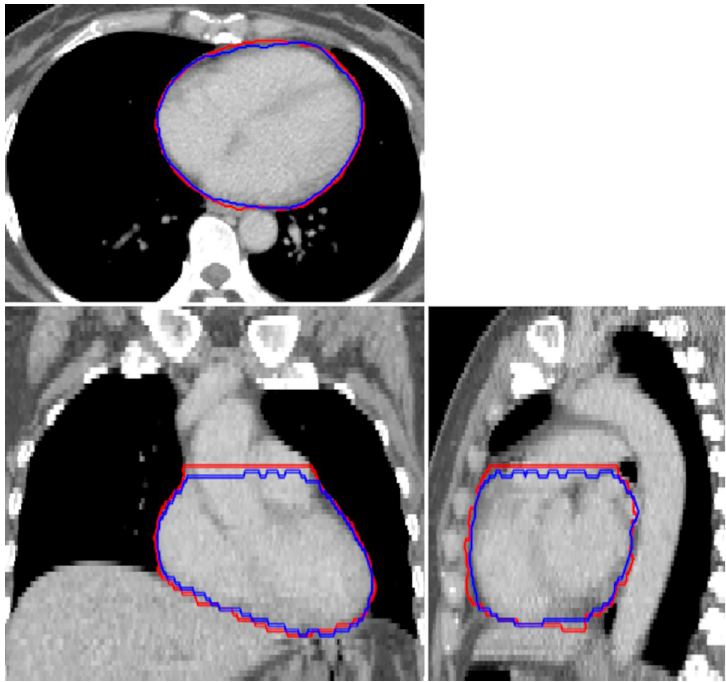
Fig 1. Representative example of an automatic segmentation (blue) compared to manual contouring (red) of the whole heart. The imaging volume shown corresponds to the automatically cropped region, defined using the bounding box of the lungs.